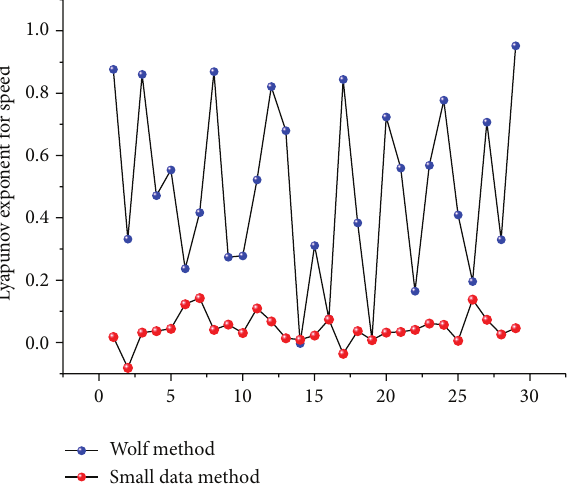
Figure 7: The largest Lyapunov exponents of flow time series from 29 detectors. Results for flow temporal sequence by both methods show that the exponents are positive except at the 26th detector and values at the 7th detector location are larger than those at other locations in the spatial sequence.